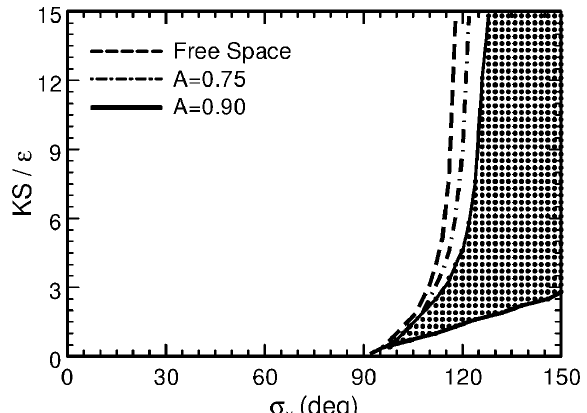
FIG. 7. Oscillations of the normalized beam envelope ~ aa (cid:4) p 5. Plot of the unstable regions in the dimensionless X= (cid:5)(cid:5)(cid:5)(cid:5)(cid:5)(cid:5) S" for both free-space and cylindrical conducting pipe parameter space for the beam envelope evolution with + (cid:4) (cid:4) 130 (cid:1) , and A (cid:4) ~ aa = ^ RR (cid:4) 0 : 9 , corre- cases at ^ KK (cid:4) 10 : 0 , (cid:1) v 0 0 : 5 and g (cid:4) 0 for three cases corresponding to (a) R (cid:4) 1 (free sponding to a point in Fig. 5 where the envelopes are unstable = ^ RR (cid:4) 0 : 75 , and (c) A (cid:4) ~ aa = ^ RR (cid:4) 0 : 90 . Here, space), (b) A (cid:4) ~ aa in both free space and cylindrical 0 0 the shaded region is the unstable region for the beam envelope = ^ RR (cid:4) 0 : 90 evolution with image-charge effects and A (cid:4) ~ aa 0 corresponding to (a) R (cid:4) 1 (free space), (b) A (cid:4) = ^ RR (cid:4) 0 : 75 (with cylindrical conducting pipe), and (c) ~ aa 0 A (cid:4) ~ aa = ^ RR (cid:4) 0 : 90 (with cylindrical conducting pipe). As 0